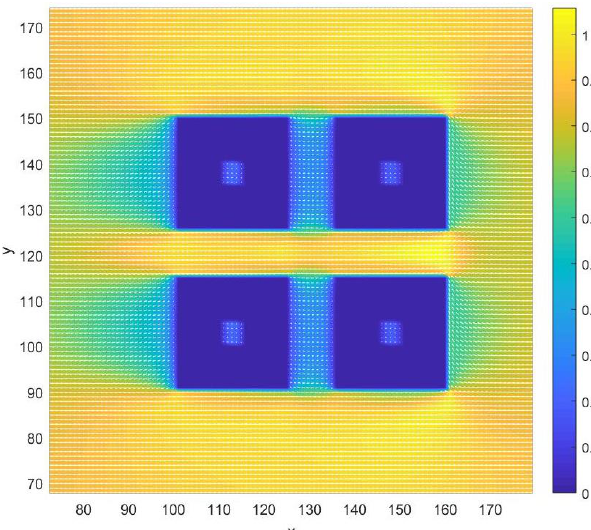
Fig. 2. Horizontal field (colour map) of velocity magnitude U [m/s] at the roof level (the undisturbed velocity U 0 is 2.3 m/s from the right), with the velocity vectors in white, for the configuration W5L05.